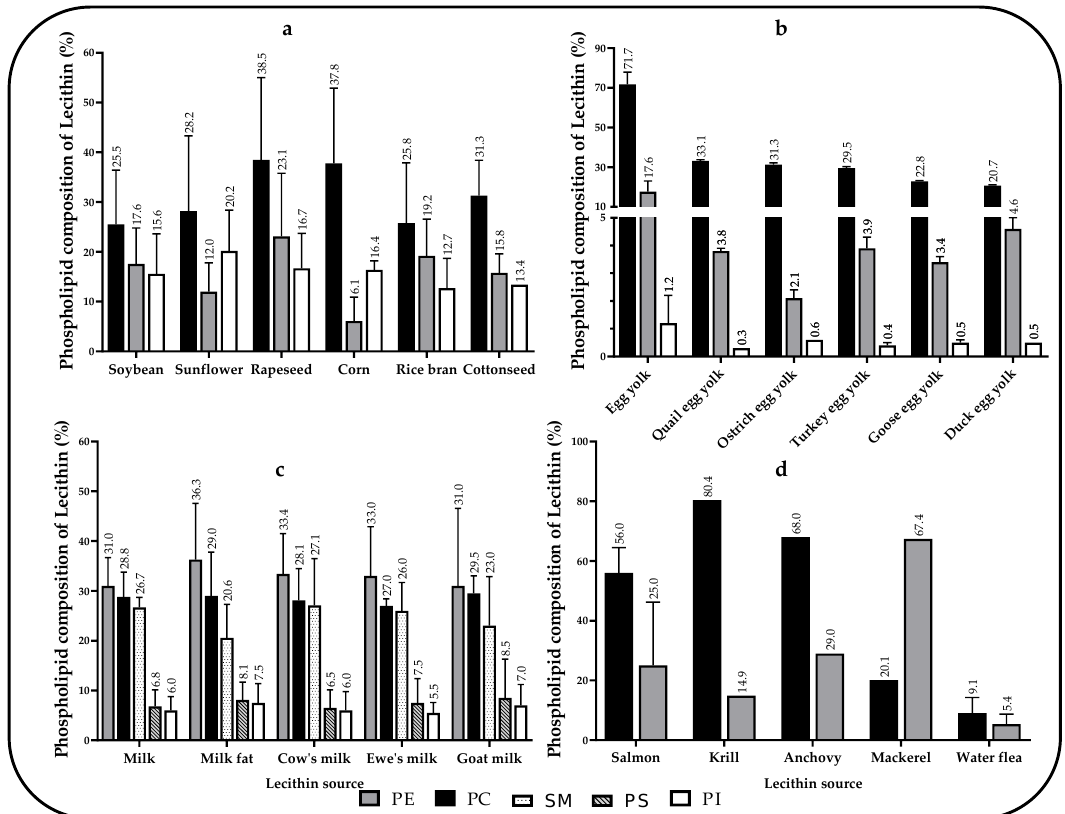
Figure 4. ( a ) Average composition of phospholipids in the main plant sources. ( b ) Average phospholipid composition in egg yolk. ( c ) Average phospholipid composition in milk. ( d ) Average composition of lecithin phospholipids from marine animals. (PE: Phosphatidylethanolamine, PC: Phosphatidylcholine, SM: Sphingomyelin, PS: Phosphatidylserine, PI: Phosphatidylinositol ).